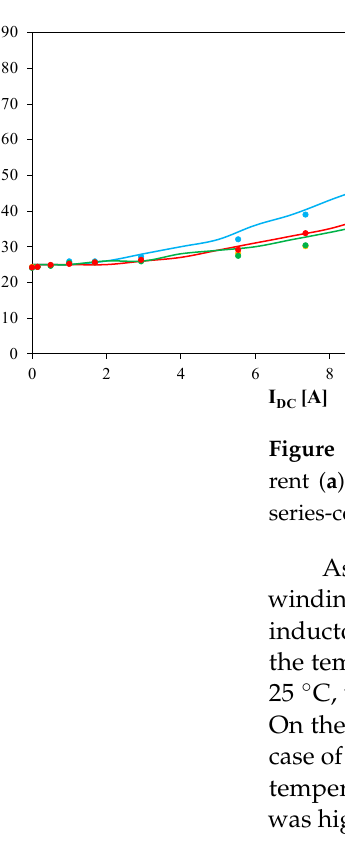
Figure 15. Dependence of the inductor core temperature on the direct current IDC when the current flows through one, two, or three windings connected in series. As expected, an increase in the number of windings in which power was dissipated caused a rise in the core temperature. In the case when the power was dissipated in only one winding, the temperature of the core T C1 at I DC = 14 A was equal to 59 °C. An increase in the number of windings in which the power was dissipated from one to three caused an increase in the temperature of T C123 to almost 100 °C. As can be seen, the increase in the temperature of the inductor core with an increase in the number windings in which the power was dissipated was non ‐ linear, which was shown in Section 2. Additionally, it is worth noting that good agreement was obtained between the results of the calculations and measurements, and the difference between them did not exceed 5%.